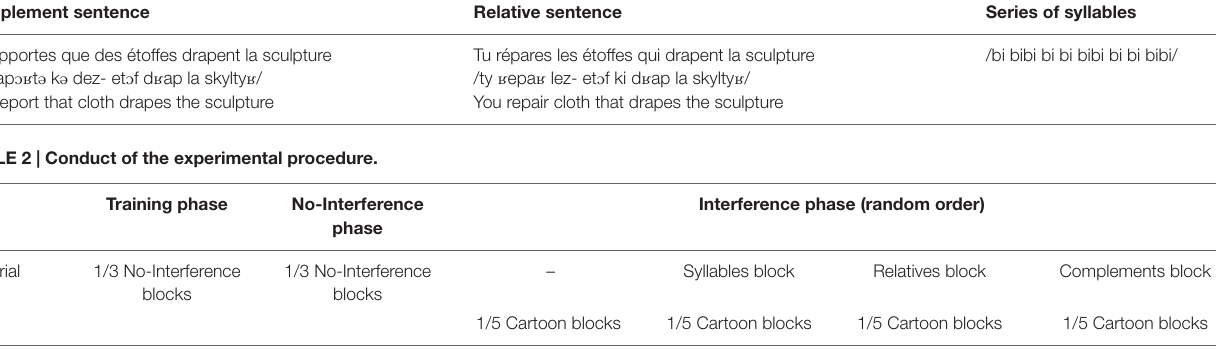
TABLE 1 | Examples of complement sentences, relative sentences, and series of syllables, presented as triplets. Complement sentence